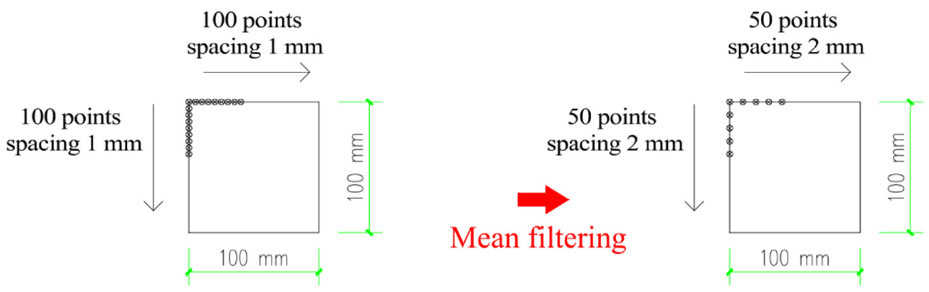
Figure 5. Grid data diagram of pavement profile in 150 × 150 area.